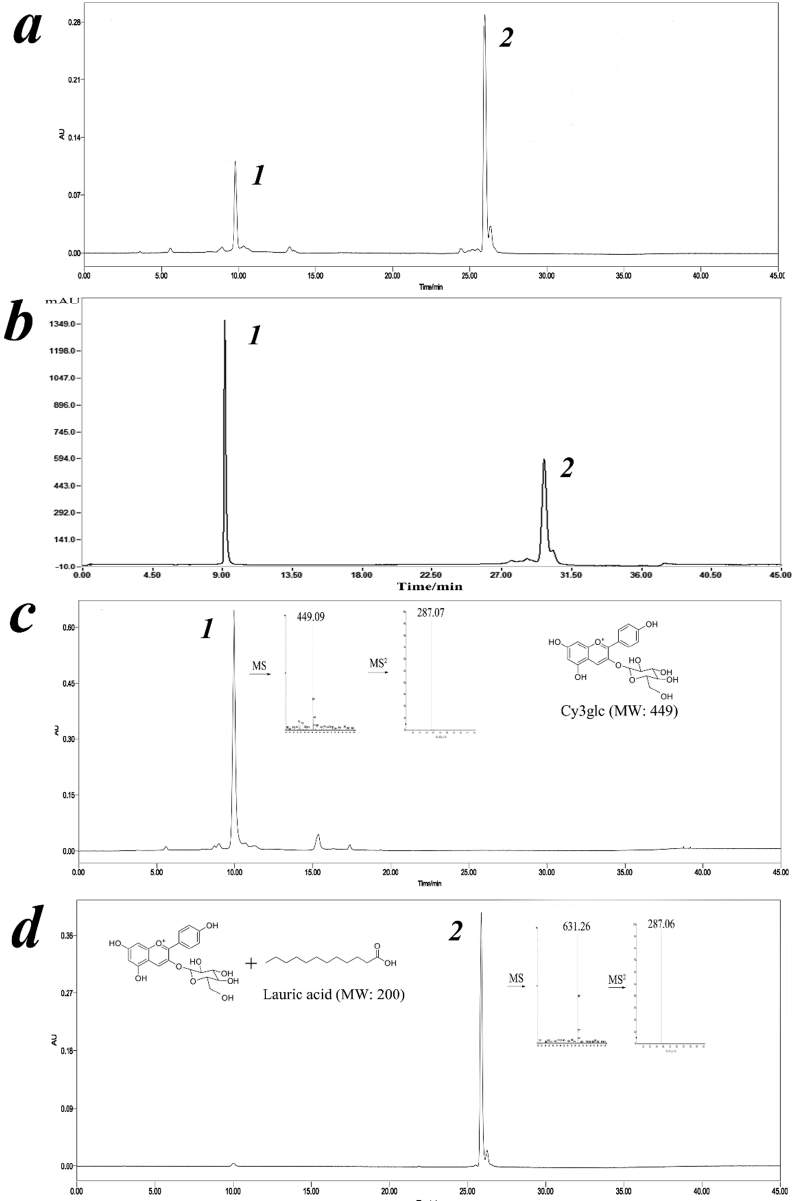
Figure 2. HPLC chromatogram of the reaction mixture to determine the Cy3glc acylation yield ( a ), semi-preparative liquid chromatogram of the reaction mixture to obtain Cy3glc and Cy3glc-C12 ( b ), and HPLC-MS/MS spectra of Cy3glc ( c ) and Cy3glc-C12 ( d ).